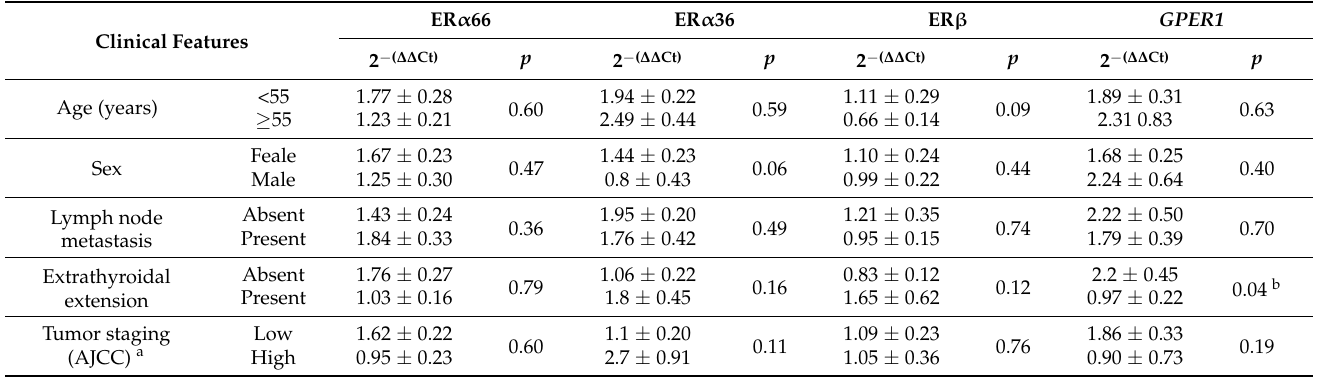
Figure 3. Differences in ERs expression between normal and papillary thyroid carcinoma (PTC; tumor) samples from male and female patients as determined by RT-qPCR: ( A ) ER α 66, ( B ) ER α 36, ( C ) ER β , and ( D ) GPER1 . In samples from female patients, the expression of ER β and GPER1 is significantly lower in PTC specimens than in adjacent normal tissues. In contrast, the expression of ER α 66 and ER α 36 in PTC specimens is significantly lower than in adjacent normal tissues in both male and female patients; *** p < 0.001, ** p < 0.005, * p < 0.05. N.S.: not significant. Table 2. Association of estrogen receptor (ER) mRNA expression levels with the clinicopathological features of papillary thyroid carcinoma (PTC) cases ( n =